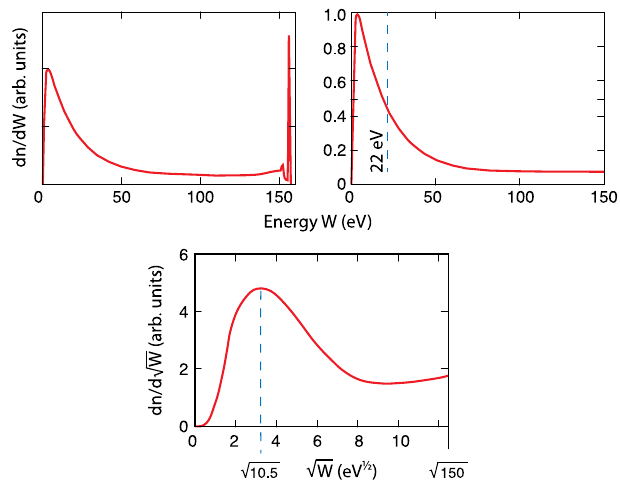
FIG. 2. Energy distribution of secondary electrons emitted by silver [27], its analytically obtained approximation, and distri- bution with respect to square root of energy. Energy of primary electrons is about 150 eV.